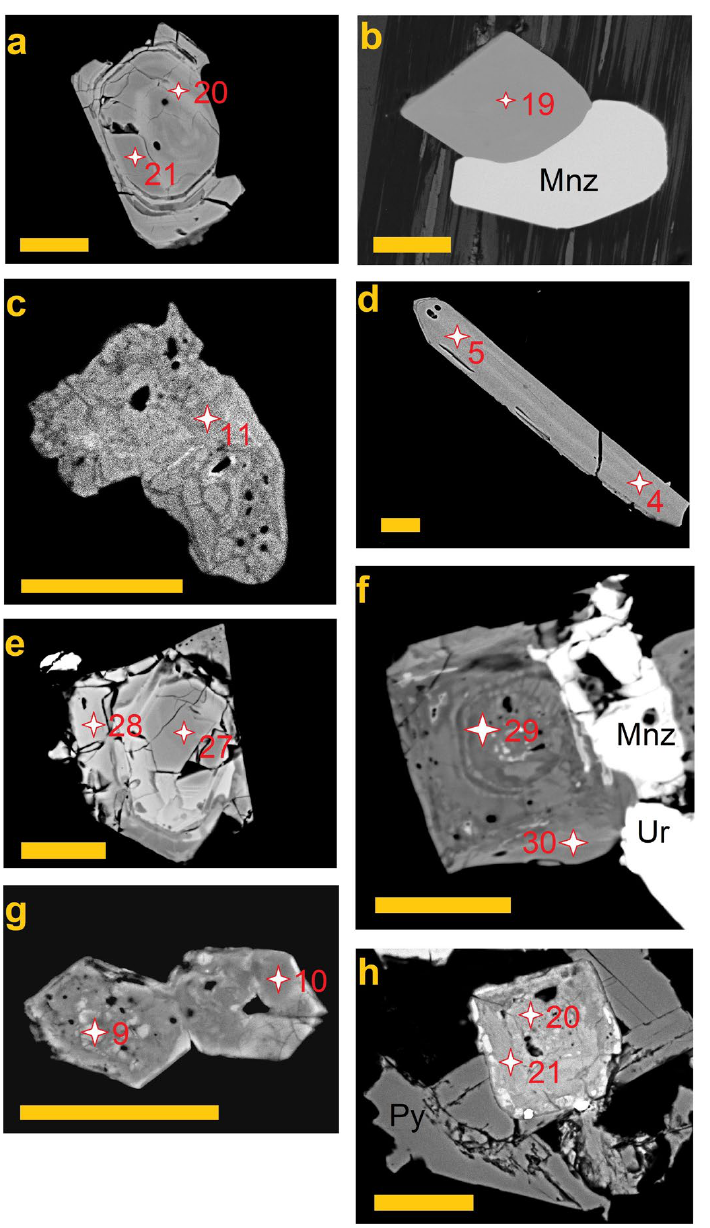
Figure 12. Back-scattered electron images (BSE) of typical zircon crystals with locations of EMP analyses: ( a ) a zoned crystal from porphyritic granite (#5); ( b ) a homogeneous zircon grain (dark gray) at contact with monazite (light), porphyritic granite (#5); ( c ) a strongly altered grain, porphyritic granite (#28); ( d ) a needle-like crystal, porphyritic granite (#28); ( e ) a cracked zoned crystal with a Hf-enriched rim, leucogranite (#53); ( f ) a zoned zircon crystal with a Hf-enriched rim (gray) associated with monazite and uraninite (bright), leucogranite (#53); ( g ) two small crystals with µ m-sized uraninite admixtures, leucogranite (#37); ( h , a ) zoned crystal with a lighter core, a darker mantle and a bright rim associated with pyrite (dark gray), leucogranite (#47). Scale bars 20 µ m in all cases. Stars indicate localization of EMP analyzes, compare Table 7. Mnz—monazite, Ur—uraninite, see Table 7. Table 7. Chemical composition (wt.%, EMPA) and empirical formulae of zircon, bdl = below de- tection limit.